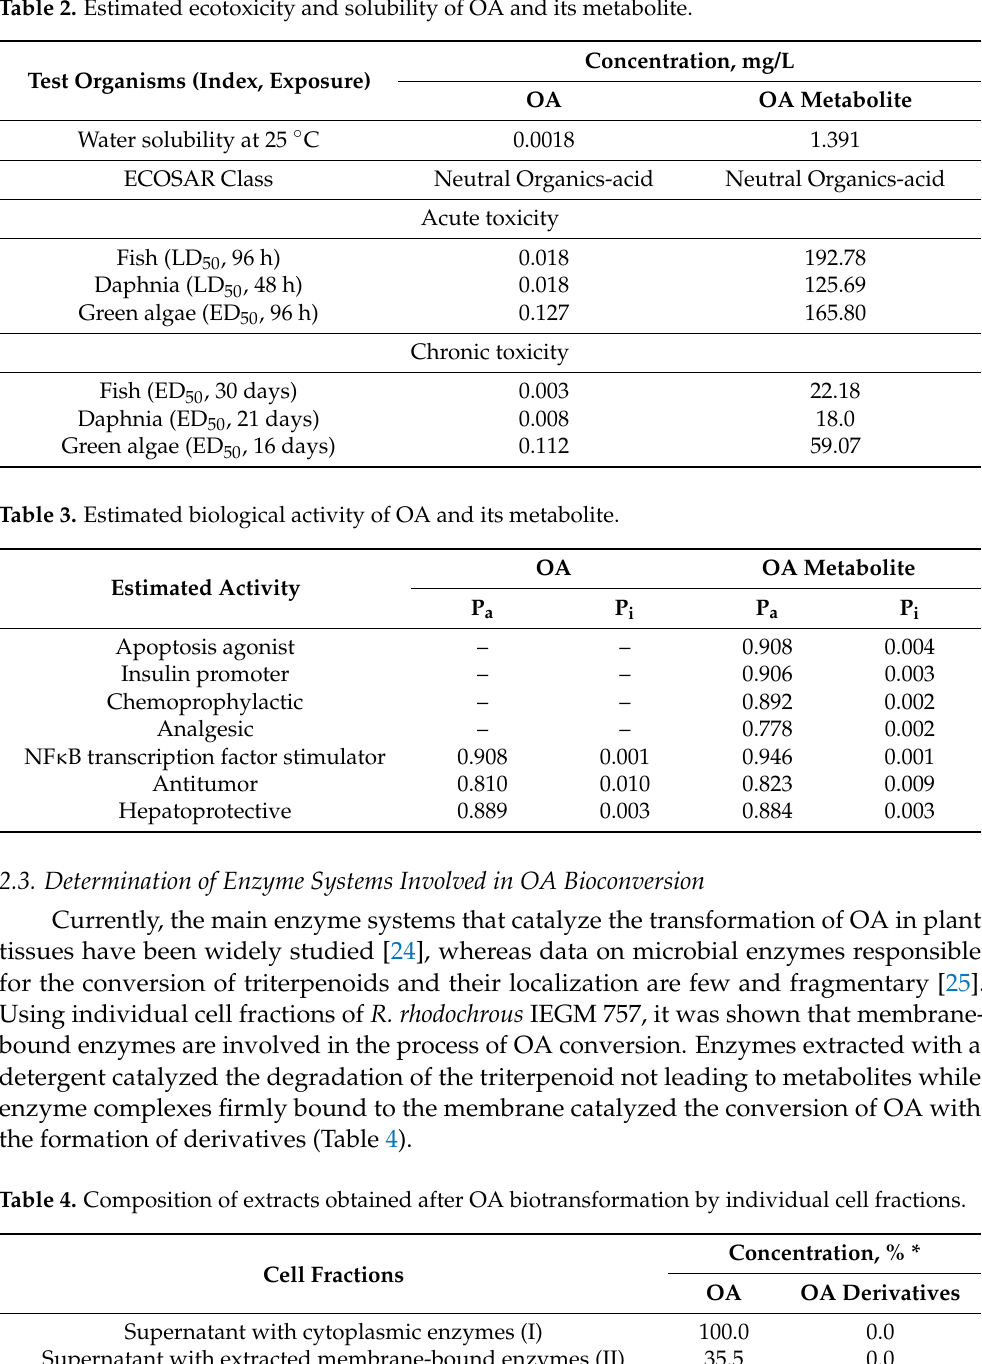
Table 2. Estimated ecotoxicity and solubility of OA and its metabolite.